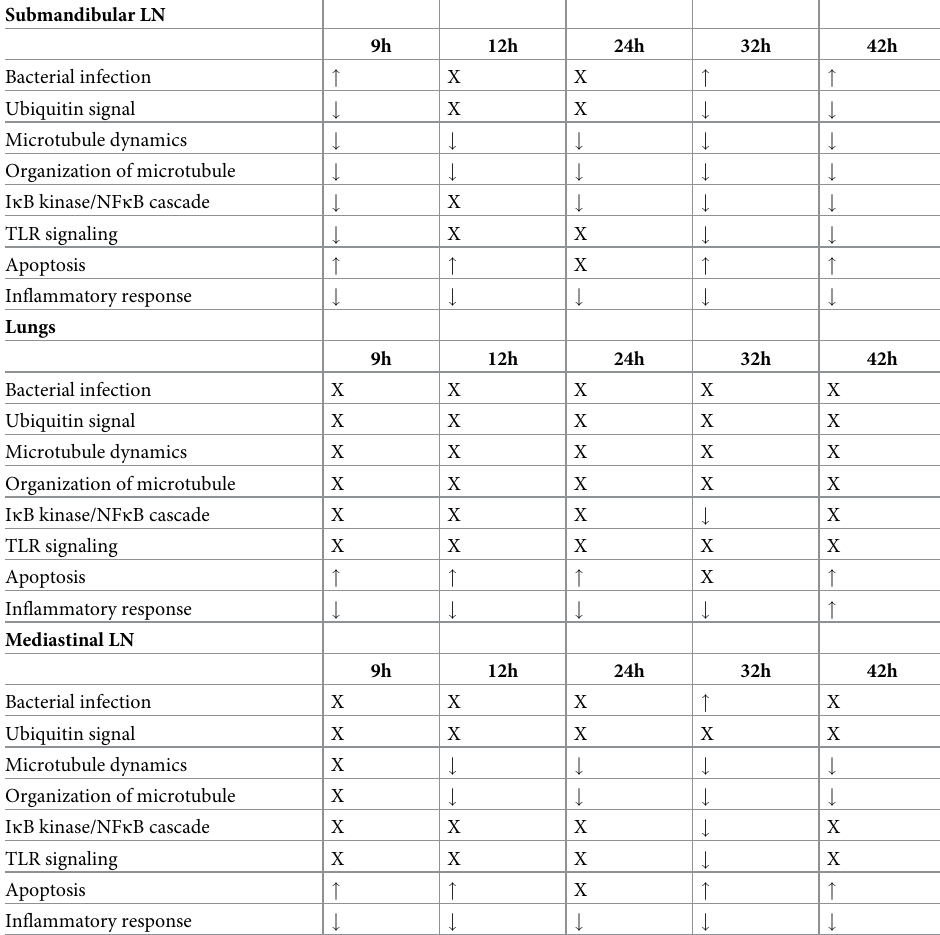
Table 2. Predicted levels of activation of different biological functions. Upward arrows and downward arrows rep- resent the activation and inhibition, respectively. The ‘x’ represents no